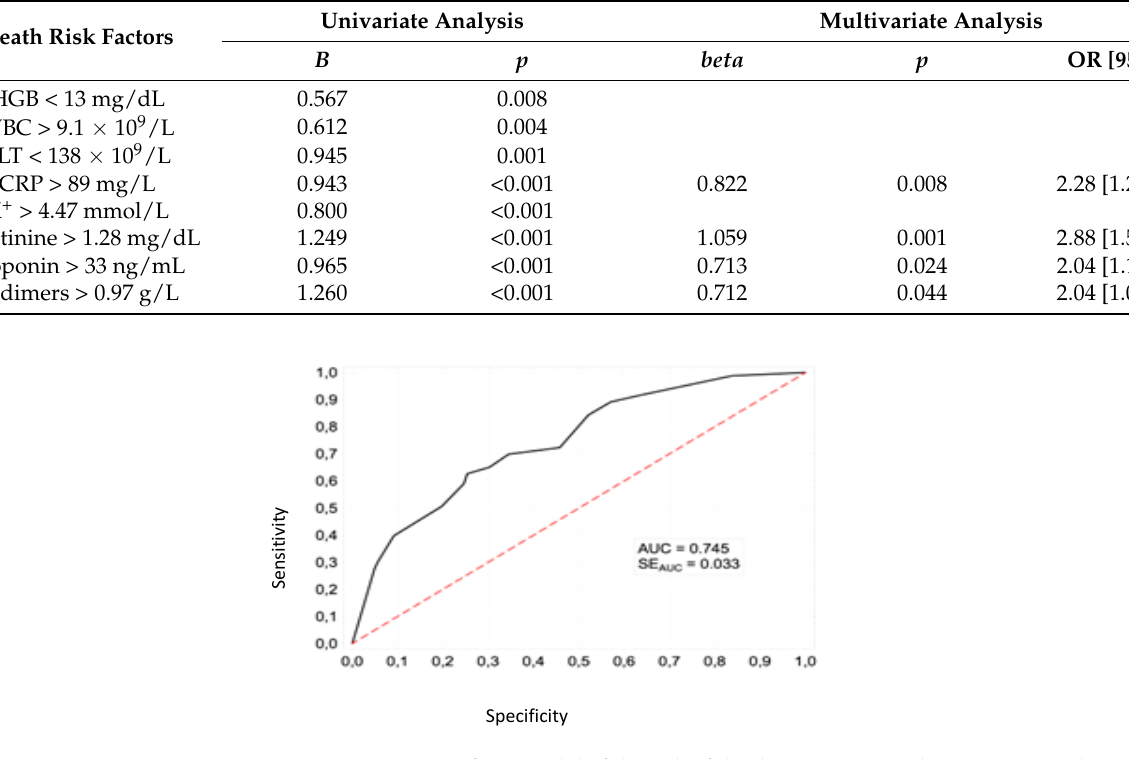
Figure 3. ROC curve for a model of the risk of death in patients with COVID-19 with cardiovascular disease.